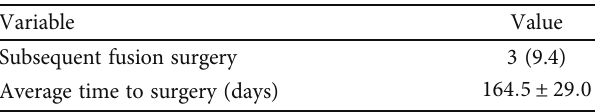
Values represent the number of patients (%) or mean ± SD